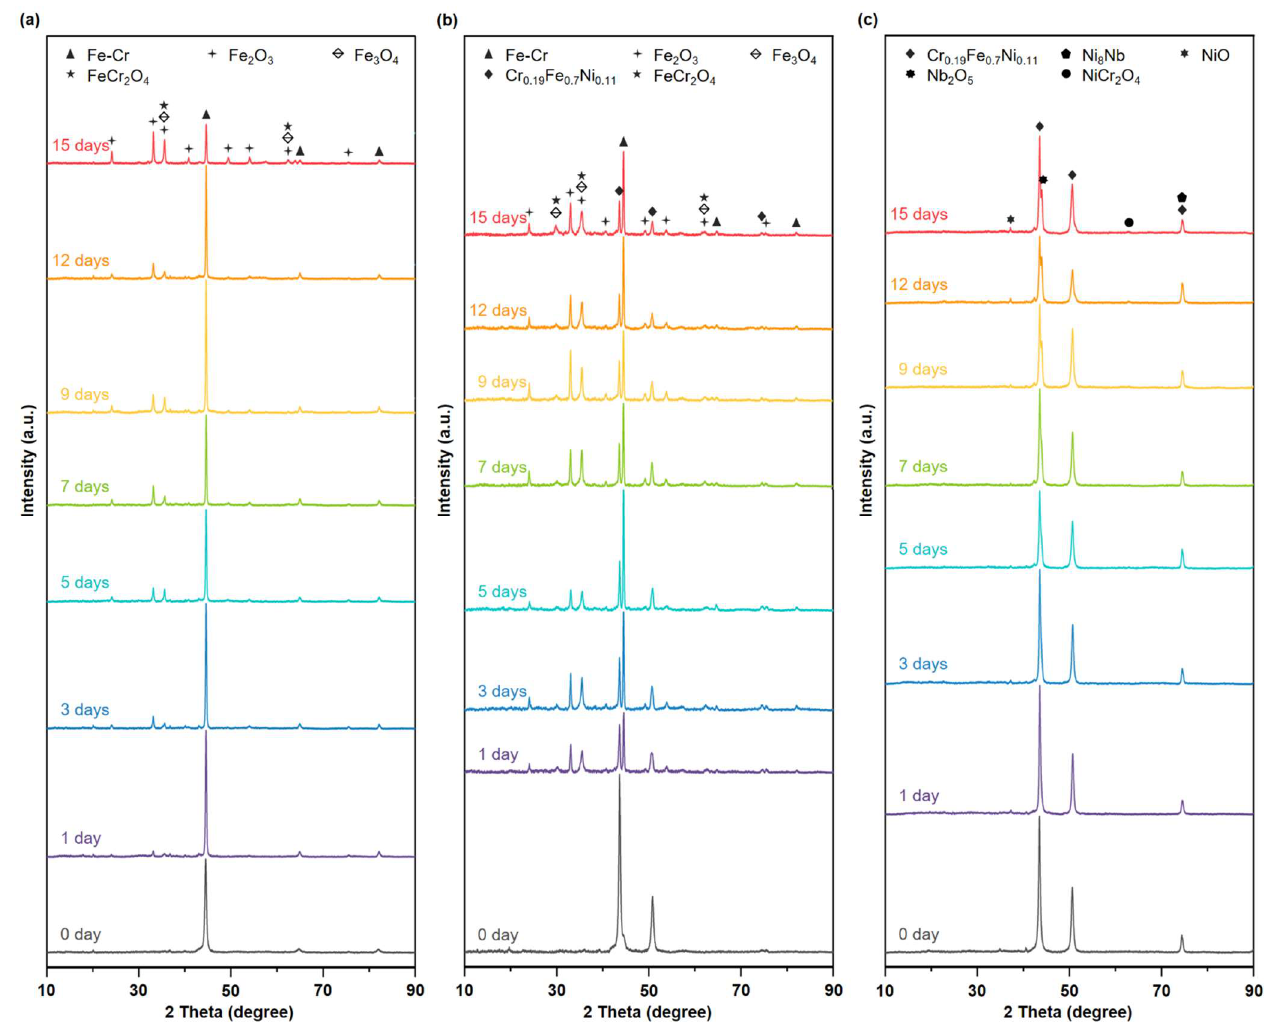
Figure 5. XRD patterns of ( a ) P91 and ( b ) 304SS and ( c ) IN625 alloys exposed to Solar Salt at 565 ◦ C for 0 day, 1 day, 3 days, 5 days, 7 days, 9 days, 12 days, and 15